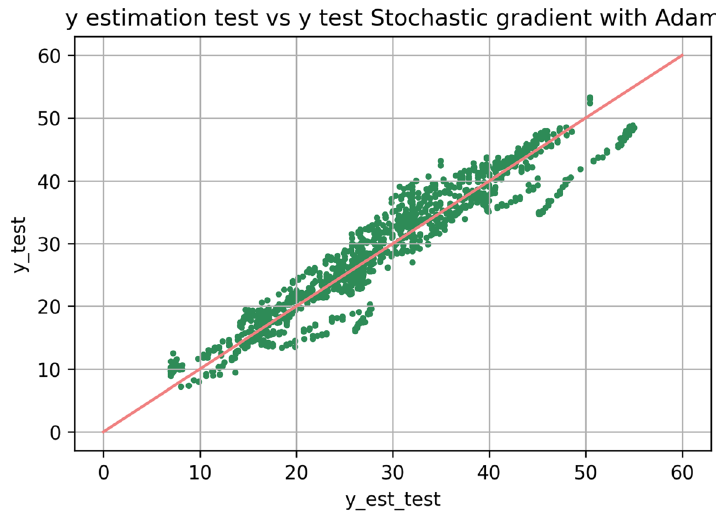
Fig. 15 y estimation test vs y